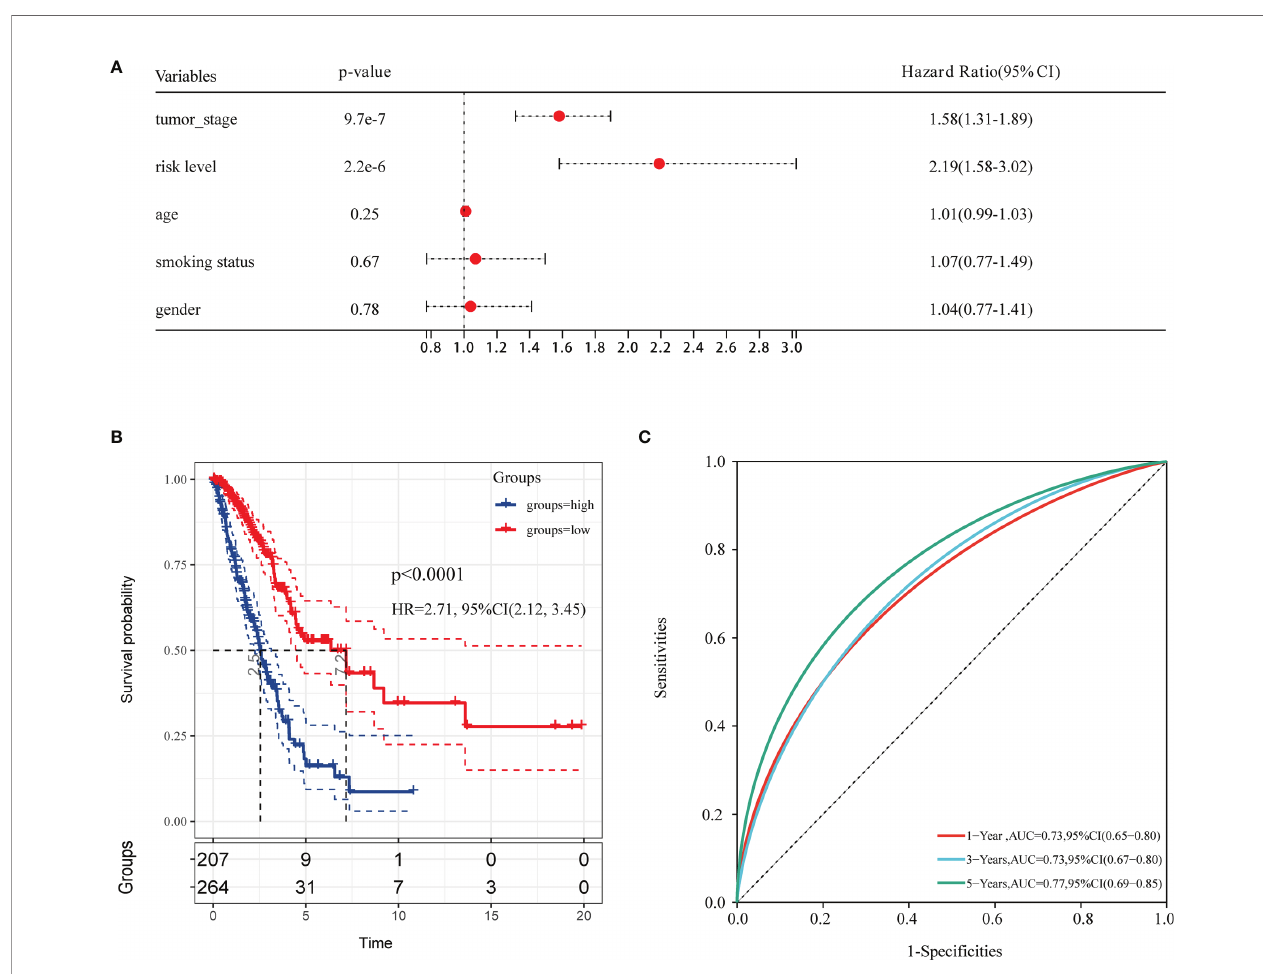
FIGURE 4 | The forest plot of multivariable Cox analysis and evaluation of the performance of the risk model in the TCGA cohort. (A) The forest plot of association between risk factors and OS in LUAD. (B) The Kaplan – Meier (KM) curve of OS in the TCGA cohort. (C) ROC curves and area under the curve (AUC) for 1-, 3-, and 5-year survival in the TCGA cohort of the risk